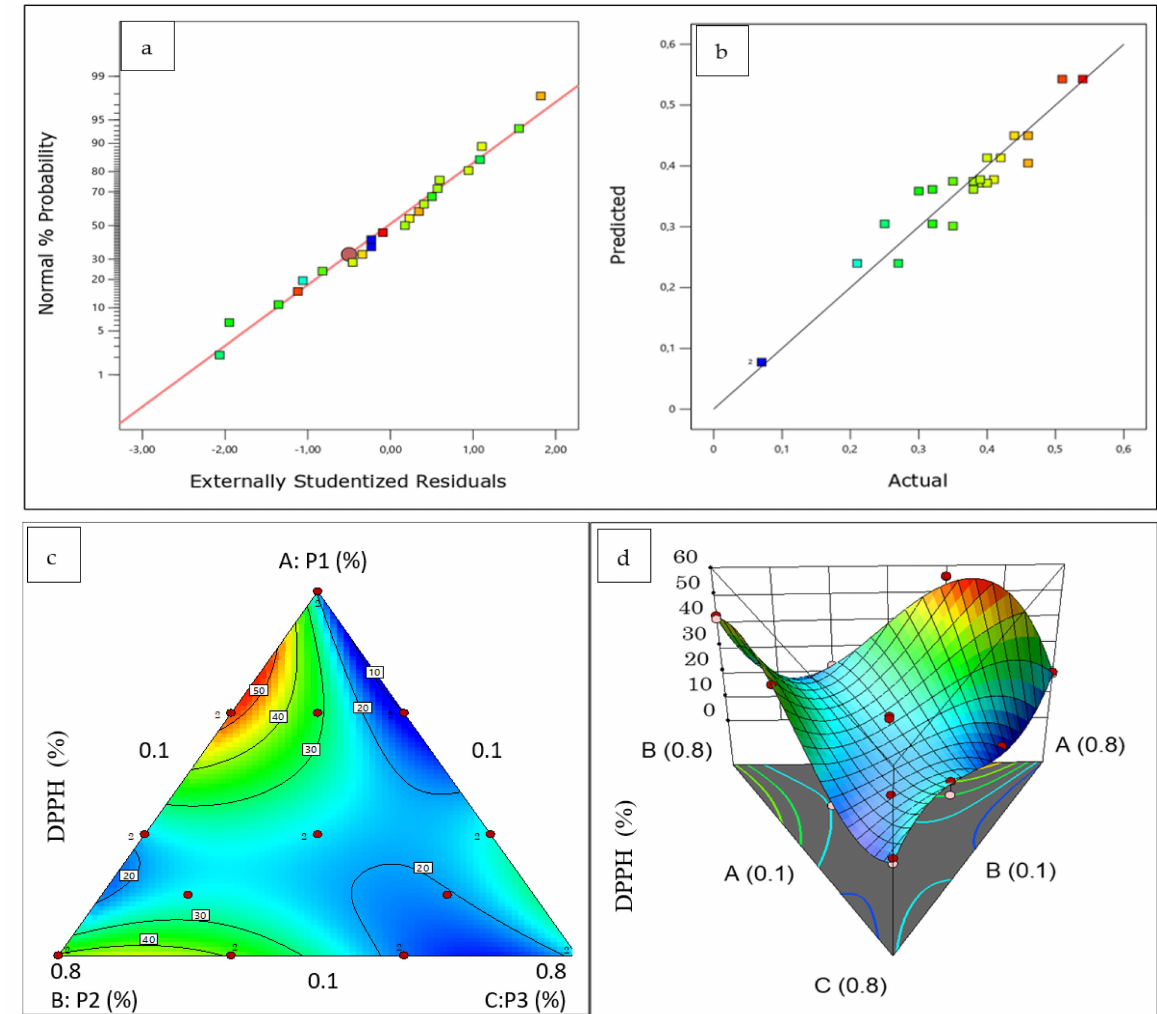
Figure 4. ( a ) Normal probability plot, ( b ) predicted versus actual plot, ( c ) contour plot, and ( d ) 3D surface plot of the effect of the three components on DPPH